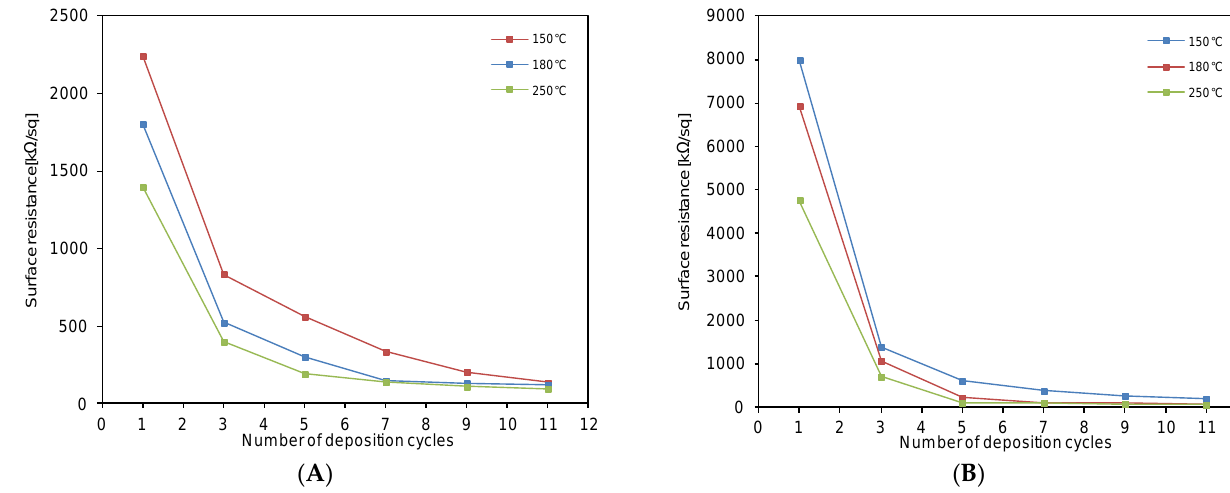
Figure 6. The dependence of surface resistance of multilayer films (rGO + /PSS) n on the number of deposition cycles; ( A ) on quartz plates; ( B ) on polyimide foil after thermal reduction at different temperatures (150 ○ C, 180 ○ C, 250 ○ C).